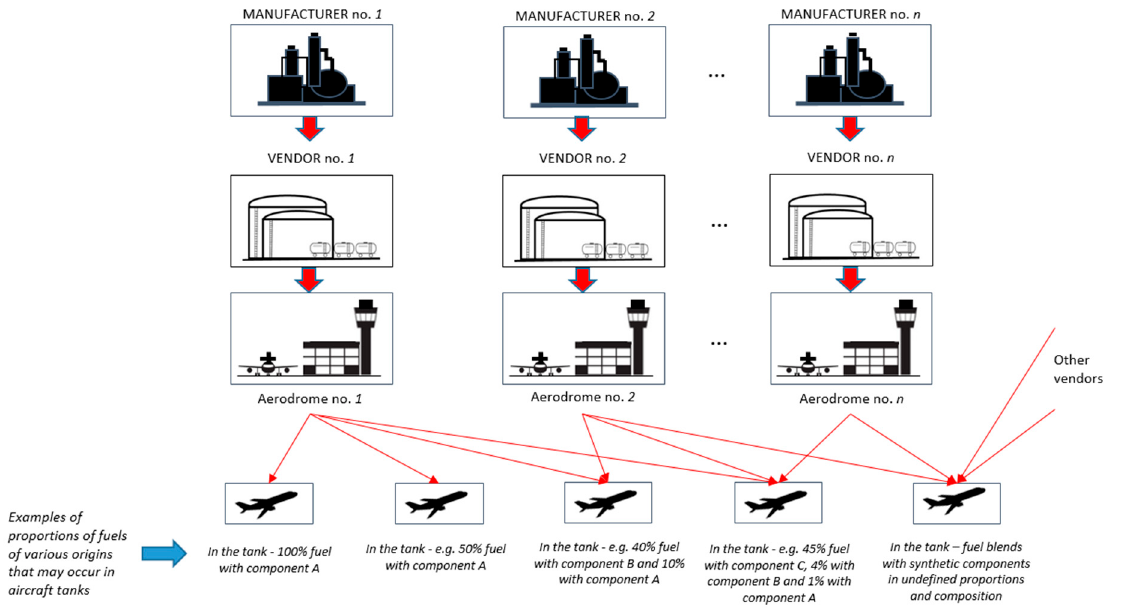
Figure 2. Technical and logistics issue: supply of aircraft with various fuels at different aero- dromes.